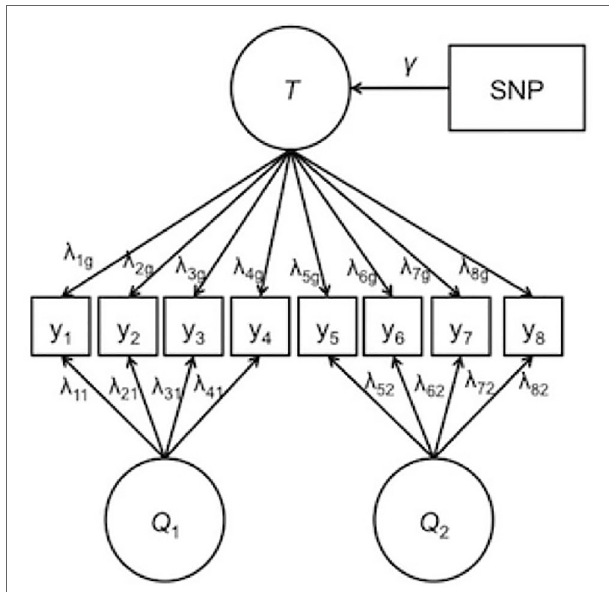
FIGUre 1 | Example of the bi-factor integration model. T represents the general trait. Q 1 and Q 2 are the specific factors corresponding to questionnaire 1 and questionnaire 2, respectively. λ represents the factor loading, γ represents the effect of the single-nucleotide polymorphism on the general trait. Thresholds and error terms are not